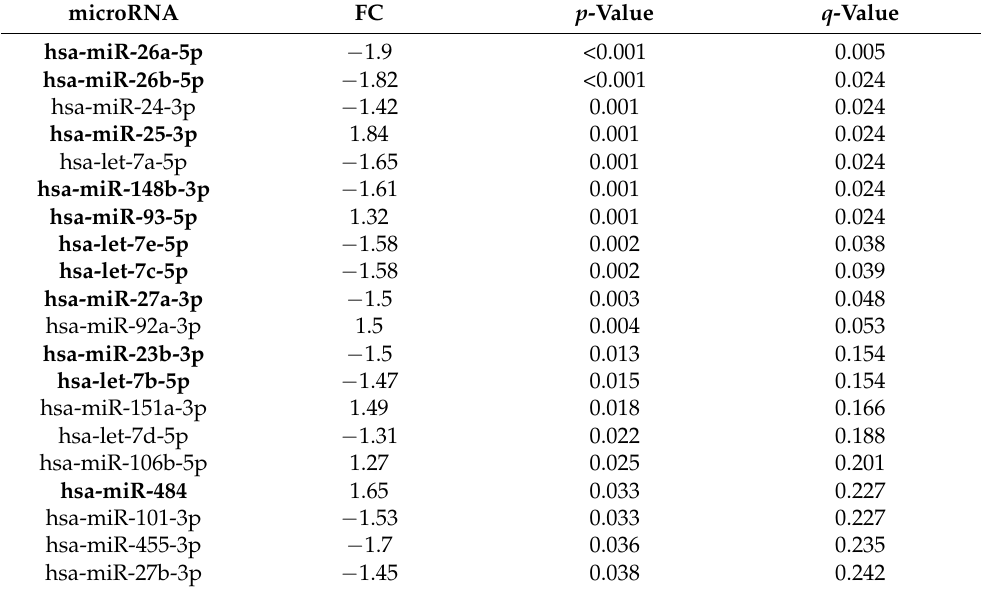
tumor size, cm, median (range) Table 2. The median fold change (FC) in miRNA expression between the samples in this study. A negative fold change indicates lower expression in pT3